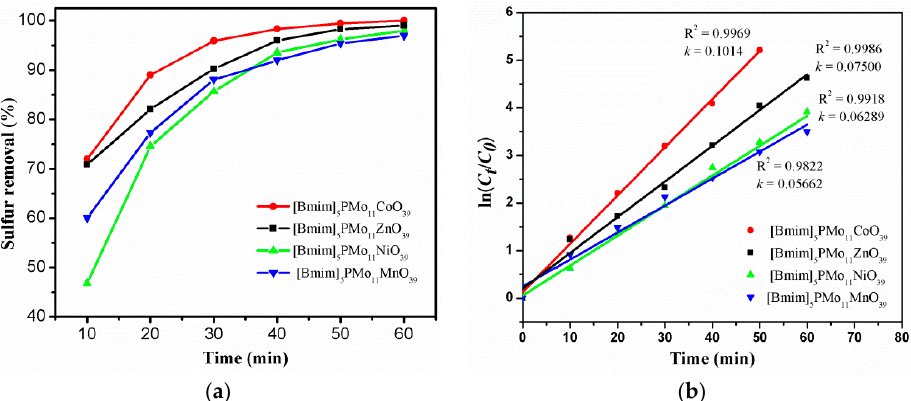
Figure 3. ( a ) Diagram of reaction conversion. ( b ) Plot of ln( C t / C 0 ) versus the reaction time for the oxidation of DBT. Conditions: Model oil = 5 mL, n (catalyst) = 4 μ mol, n (H 2 O 2 )/ n (DBT) = 5, T = 50 °C for 60 min with [Omim]BF 4 (1 mL) as the extractant.